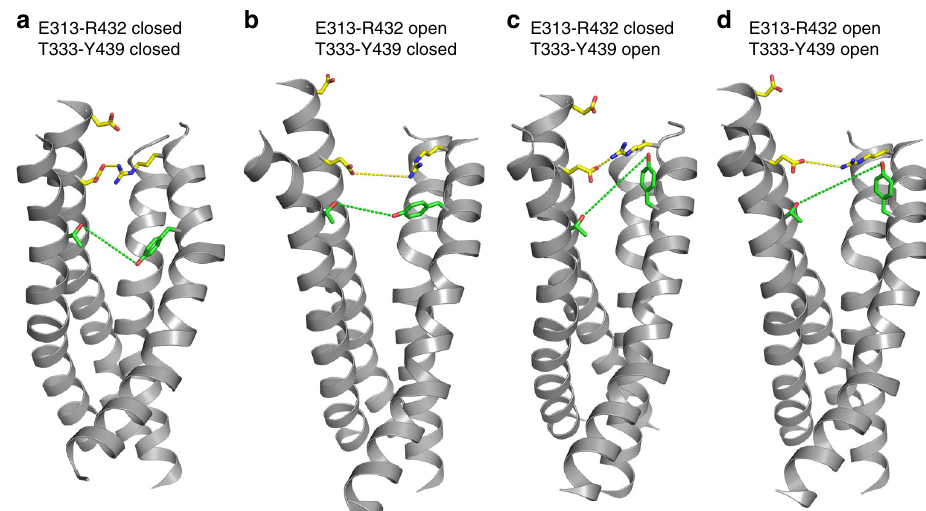
Fig. 10 Mechanistic steps involved in opening of the extracellular vestibule of the nhTMEM16 groove. a – d The nhTMEM16 groove is viewed from the plane of the membrane. For clarity only TM3-6 are shown in ribbon representation, E313, E318, and R432 are shown as sticks in CPK yellow, T333 and Y439 are shown as sticks in CPK green. Dashed lines represent the distance between the oxygen of E313 and the nitrogen of R432 (yellow) or between the oxygen of T333 and that of Y439 (green). a The groove is in the conformation from the crystal structure; b the extracellular vestibule opens, while the central constriction remains closed; c the extracellular vestibule is closed and the central constriction is open; d both constrictions are